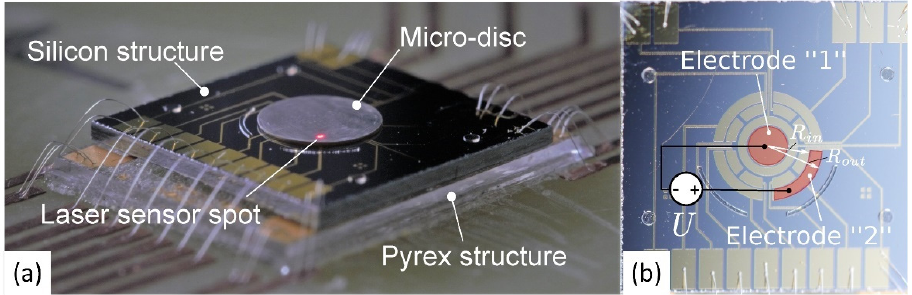
Figure 4. The prototype of microactuator-performed tilting pull-in actuation: ( a ) the fabricated prototype of the microactuator; ( b ) the set of electrodes fabricated on the top of the silicon structure, U—applied electric potential. Adapted from [45].